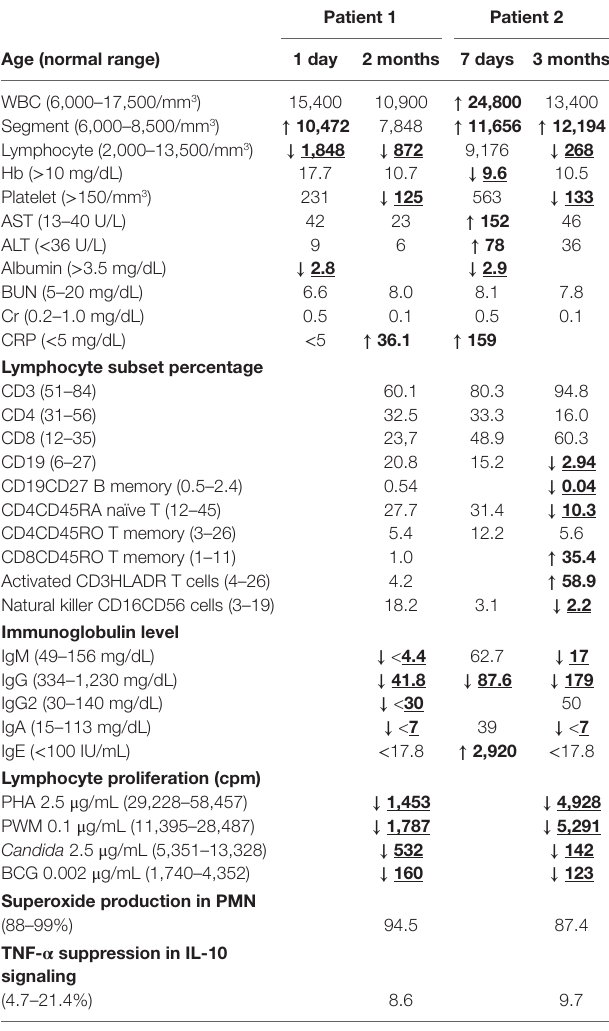
TaBle 1 | Hematogram and basic immunologic evaluations in our two female